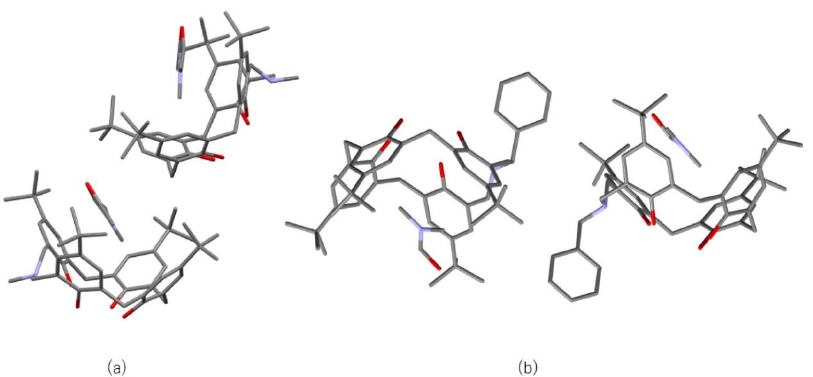
Figure 12. Molecular packing modes in the crystals of the DMF inclusion complexes. Only two molecules are shown for clarity. ( a ) DMF ⊂ p-tert -butyl- N -methyl-azacalix[3.1.1.1]arene. ( b ) DMF ⊂ p-tert -butyl- N -benzyl-azacalix[3.1.1.1]arene.